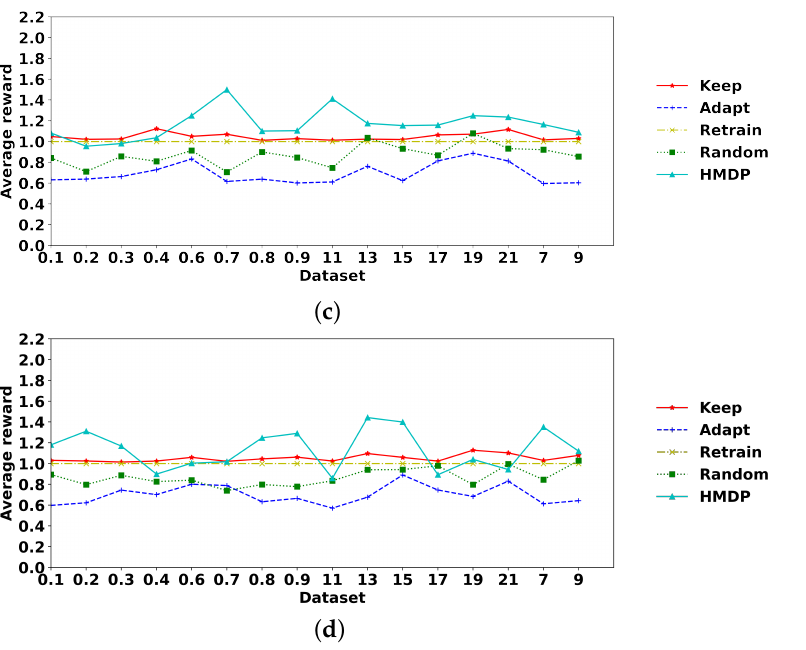
Figure 7. Performance measure under artificial datasets with a penalty of 0.5. ( a ) Sudden transition drift; ( b ) gradual transition drift; ( c ) sudden duration drift; ( d ) gradual duration